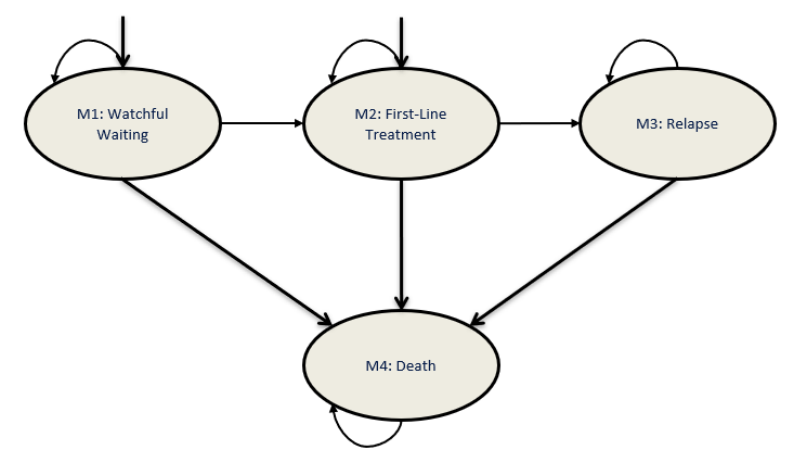
Figure 1. Markov model structure for patients with CLL. The health-state transition model comprises four health states: watchful waiting, first-line treatment, relapse and death. The Markov model developed simulates the course of patients with CLL, who may enter the model from either the watchful waiting or first-line treatment health states. CLL, chronic lymphocytic leukemia.